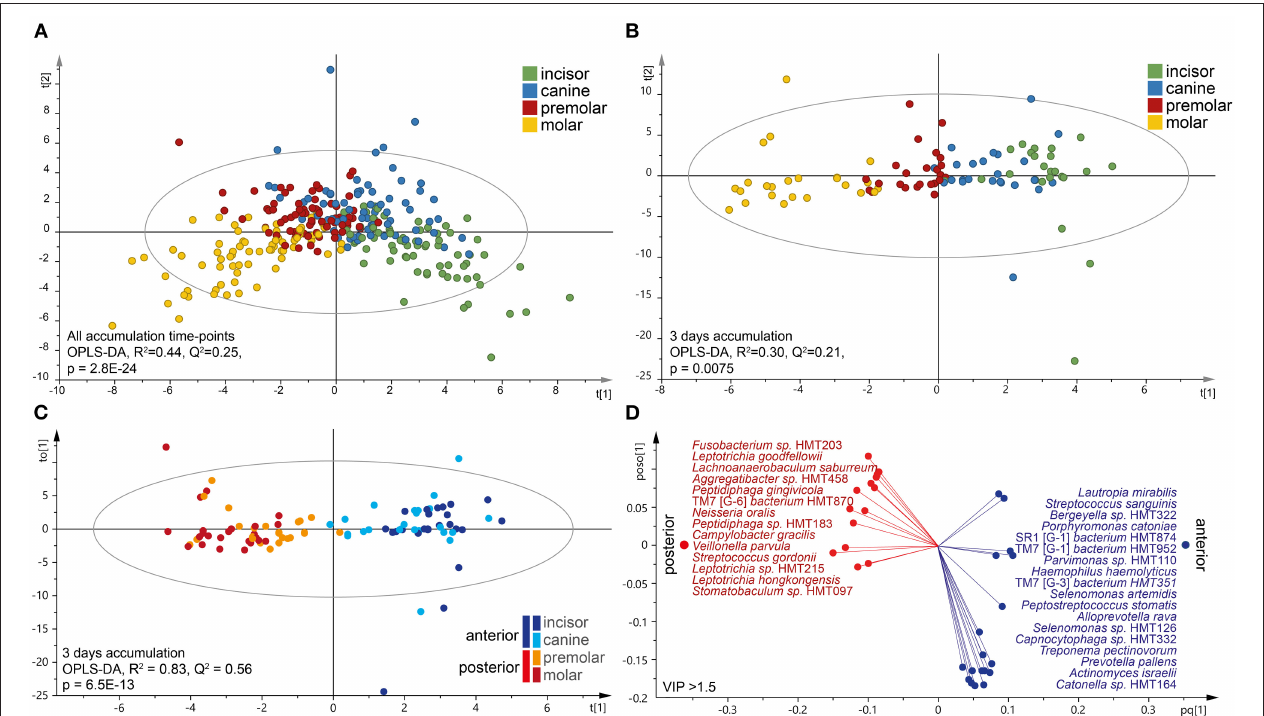
FIGURE 4 | Characteristics of the tooth microbiota in anterior and posterior tooth regions. Multivariate OPLS-DA modeling of (A) accumulation-time merged for tooth biofilm microbiota samples or (B,C) on day 3 without oral hygiene. In (B) , the four regions were modeled as separate entities, and (C) is the dichotomous evaluation of anterior vs. posterior regions. OPLS-DA outcomes are presented as score scatter plots by discrimination components t [1] and t [2]. (D) Loading scatter bi-plot includes the most influential (VIP > 1.5) species for separating the anterior (incisor and canine) and posterior (premolar and molar) regions. The horizontal axis displays the X -loading ( p ) and Y -loading ( q ) of the predictive component, and the vertical axis displays the X -loading p ( o ) and Y -loading s ( o ) for the first orthogonal component.